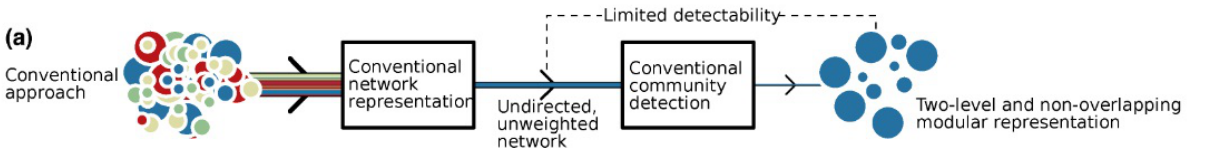
Fig. 2 Schematic diagram of random traversal